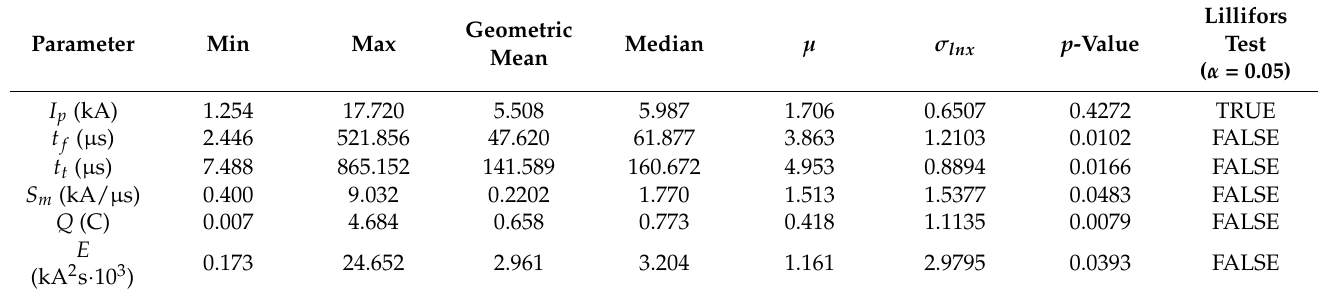
Table 6. Statistical parameters of measured subsequent negative